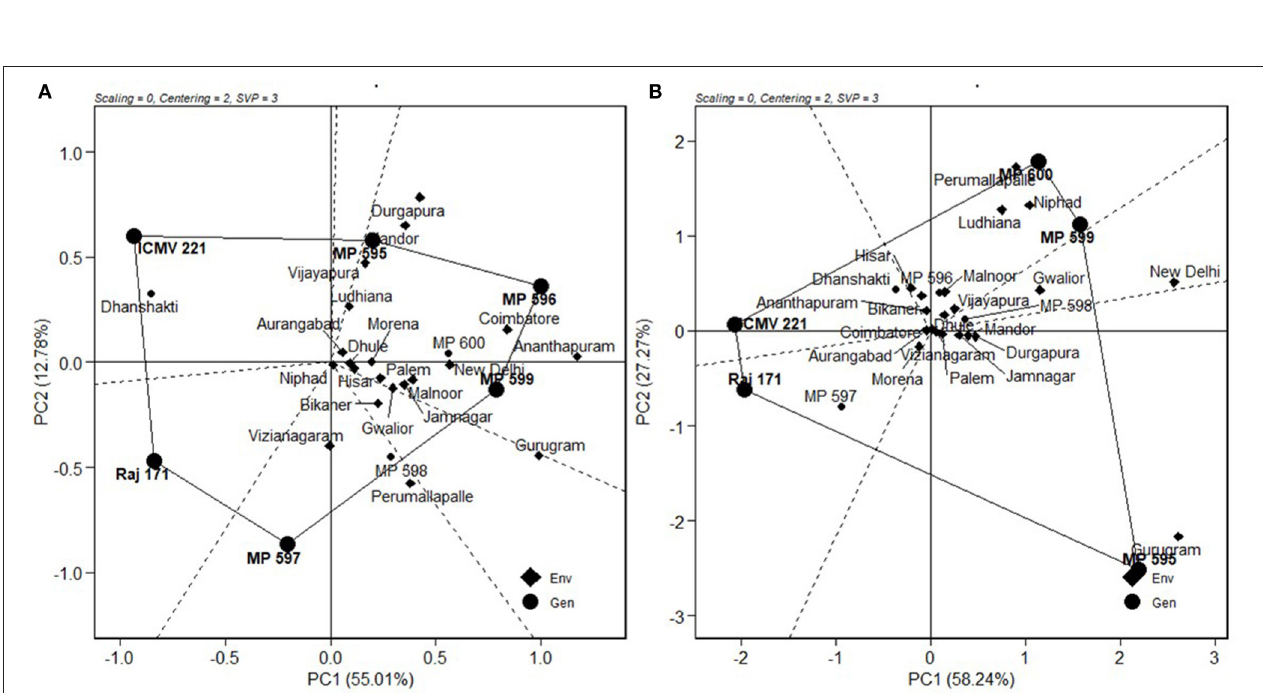
FIGURE 6 | Which-won-where analysis of the genotypes for (A) grain yield and (B) fodder yield.